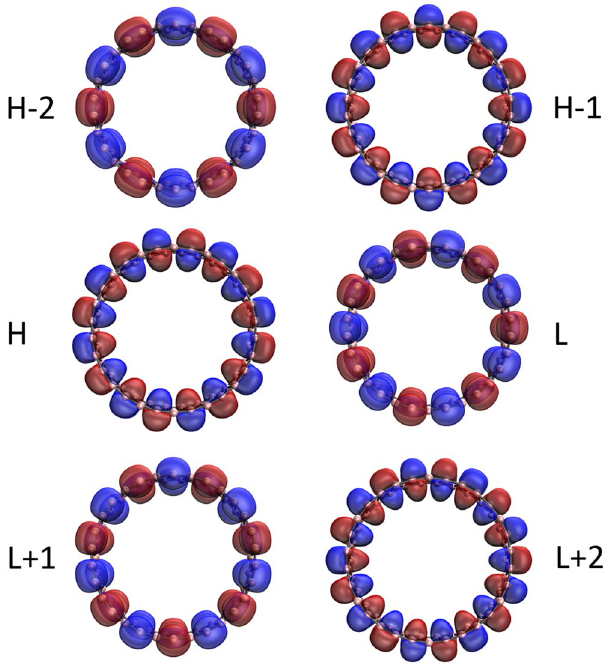
Figure 11. Visualization of the HOMO − 2 (1.841), HOMO − 1 (1.296), HOMO (1.296), LUMO (0.685), LUMO + 1 (0.685), and LUMO + 2 (0.240) for the ground state of c -BNR[2,30], obtained from spin-restricted TAO-LDA, at isovalue = 0.02 e/Å 3 . The orbital occupation numbers are shown in parentheses. Here, for simplicity, HOMO and LUMO are referred to as H and L,